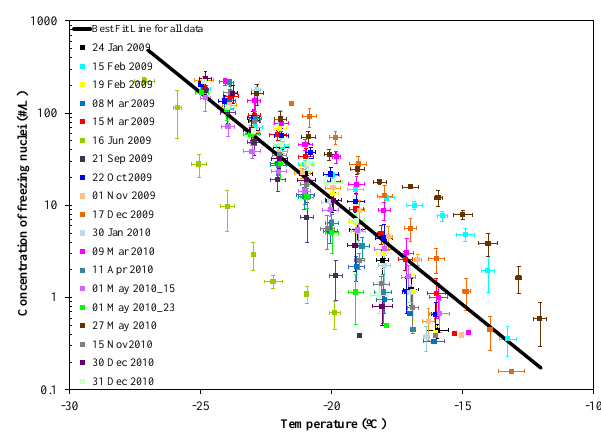
Figure 5. Activated fraction of FN calculated with standard devia- tion values for the different filters. Each color represents a different sample, and the black line is the best-fit